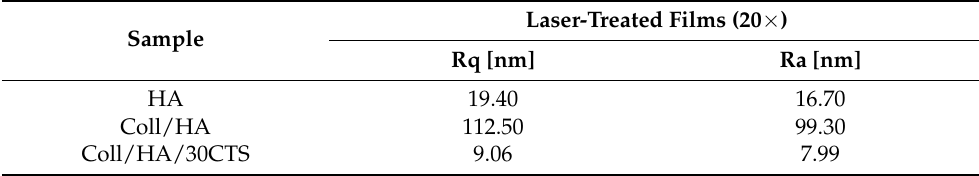
Table 1. The roughness parameters of laser-treated films based on HA, Coll/HA, and Coll/HA/30CTS.